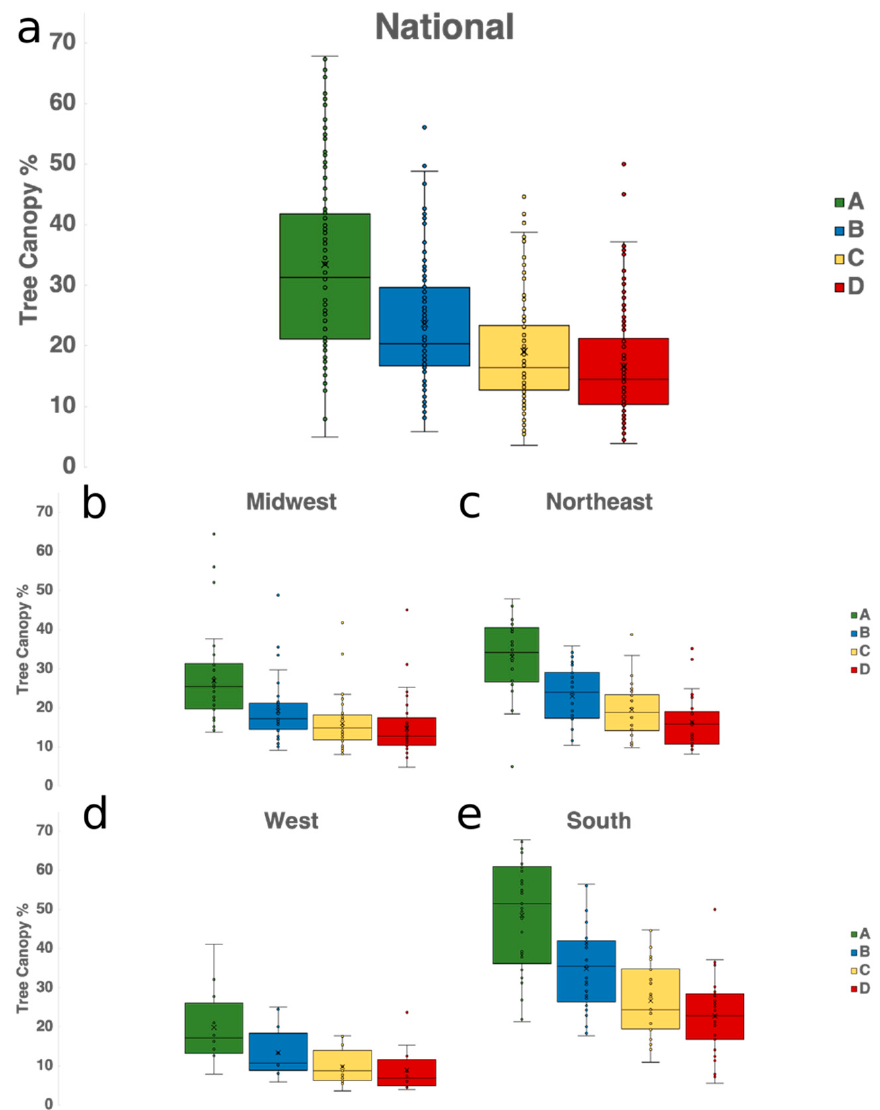
Figure 5. ( a ) National-scale averages of percent tree canopy [35,36] by HOLC security rating (Green, “Best,” A; Blue, “Still Desirable,” B; Yellow, “Definitely Declining,” C; Red, “Hazardous,” D), ( b ) same as ( a ), but for the Midwest region; ( c ) same as ( b ), but for Northeast region; ( d ) same as ( b ), but for West region; ( e ) same as ( b ), but for South region.